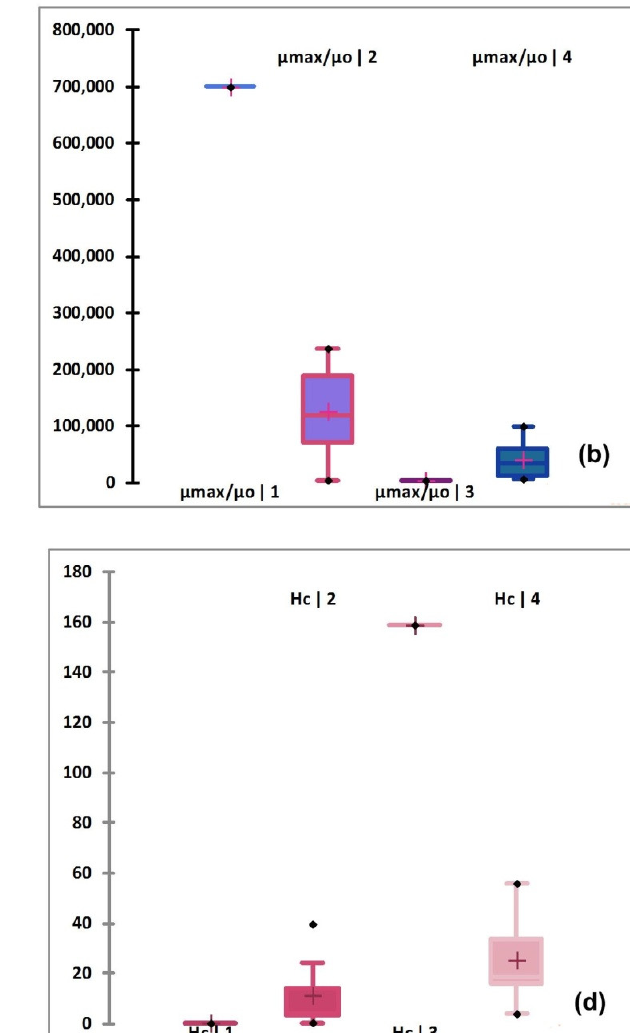
Figure 3. Box plots of ( a ) Tc; ( b ) μ max / μ o ; ( c ) Hc; ( d ) Br; ( e ) Bs; ( f ) ρ , for four clusters based on dendrogram.